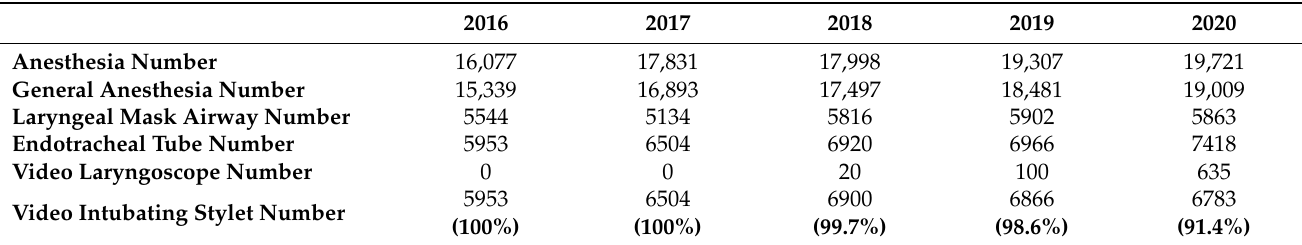
Table 1. Use coverage of video-assisted intubating stylet in the Hualien Tzu-Chi Medical Center, Hualien,